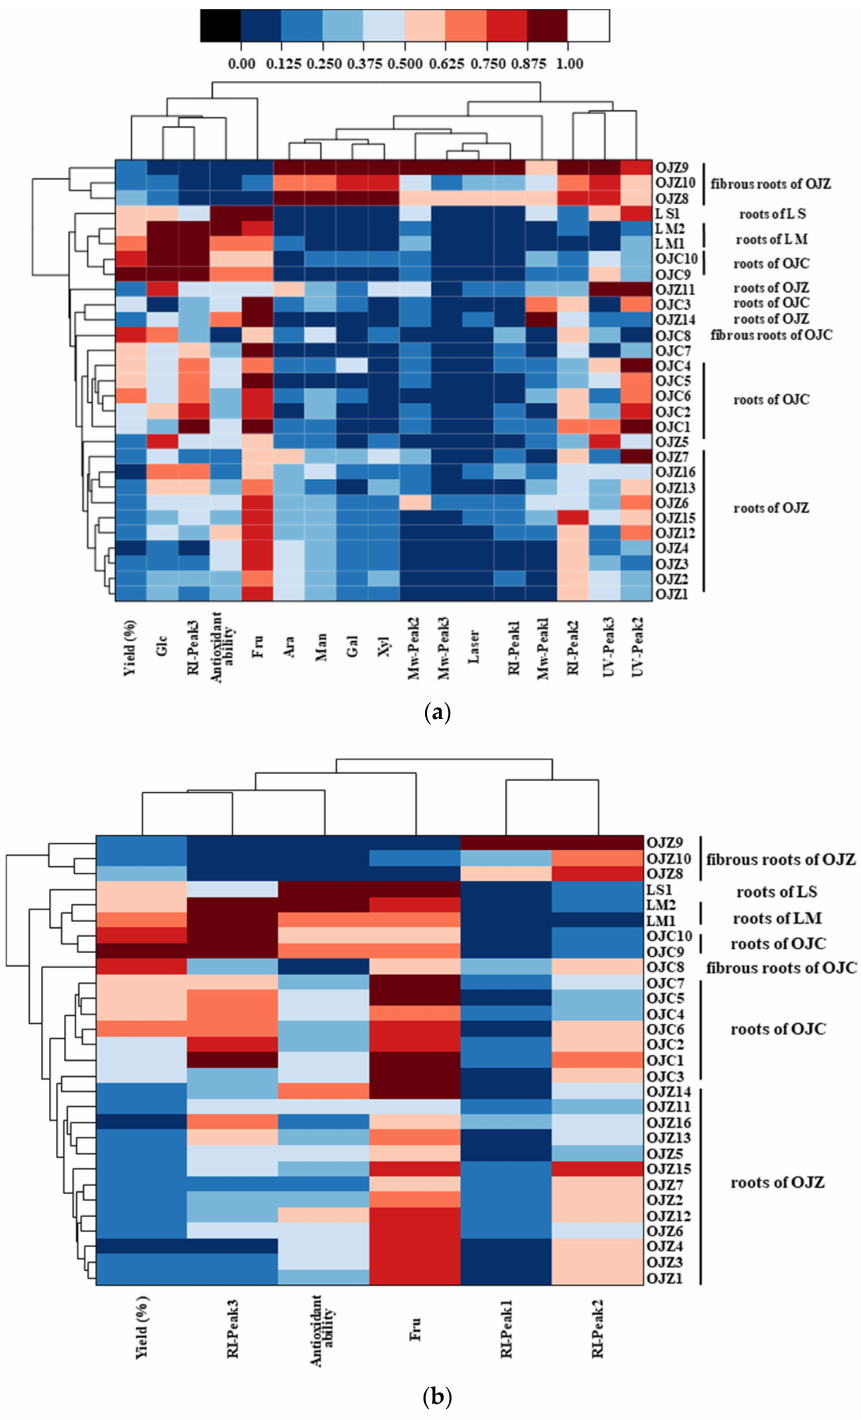
Figure 5. Hierarchical clustering and heat-map of 29 batches of MaiDong polysaccharides based on ( a ) all investigated indicators or ( b ) optimized